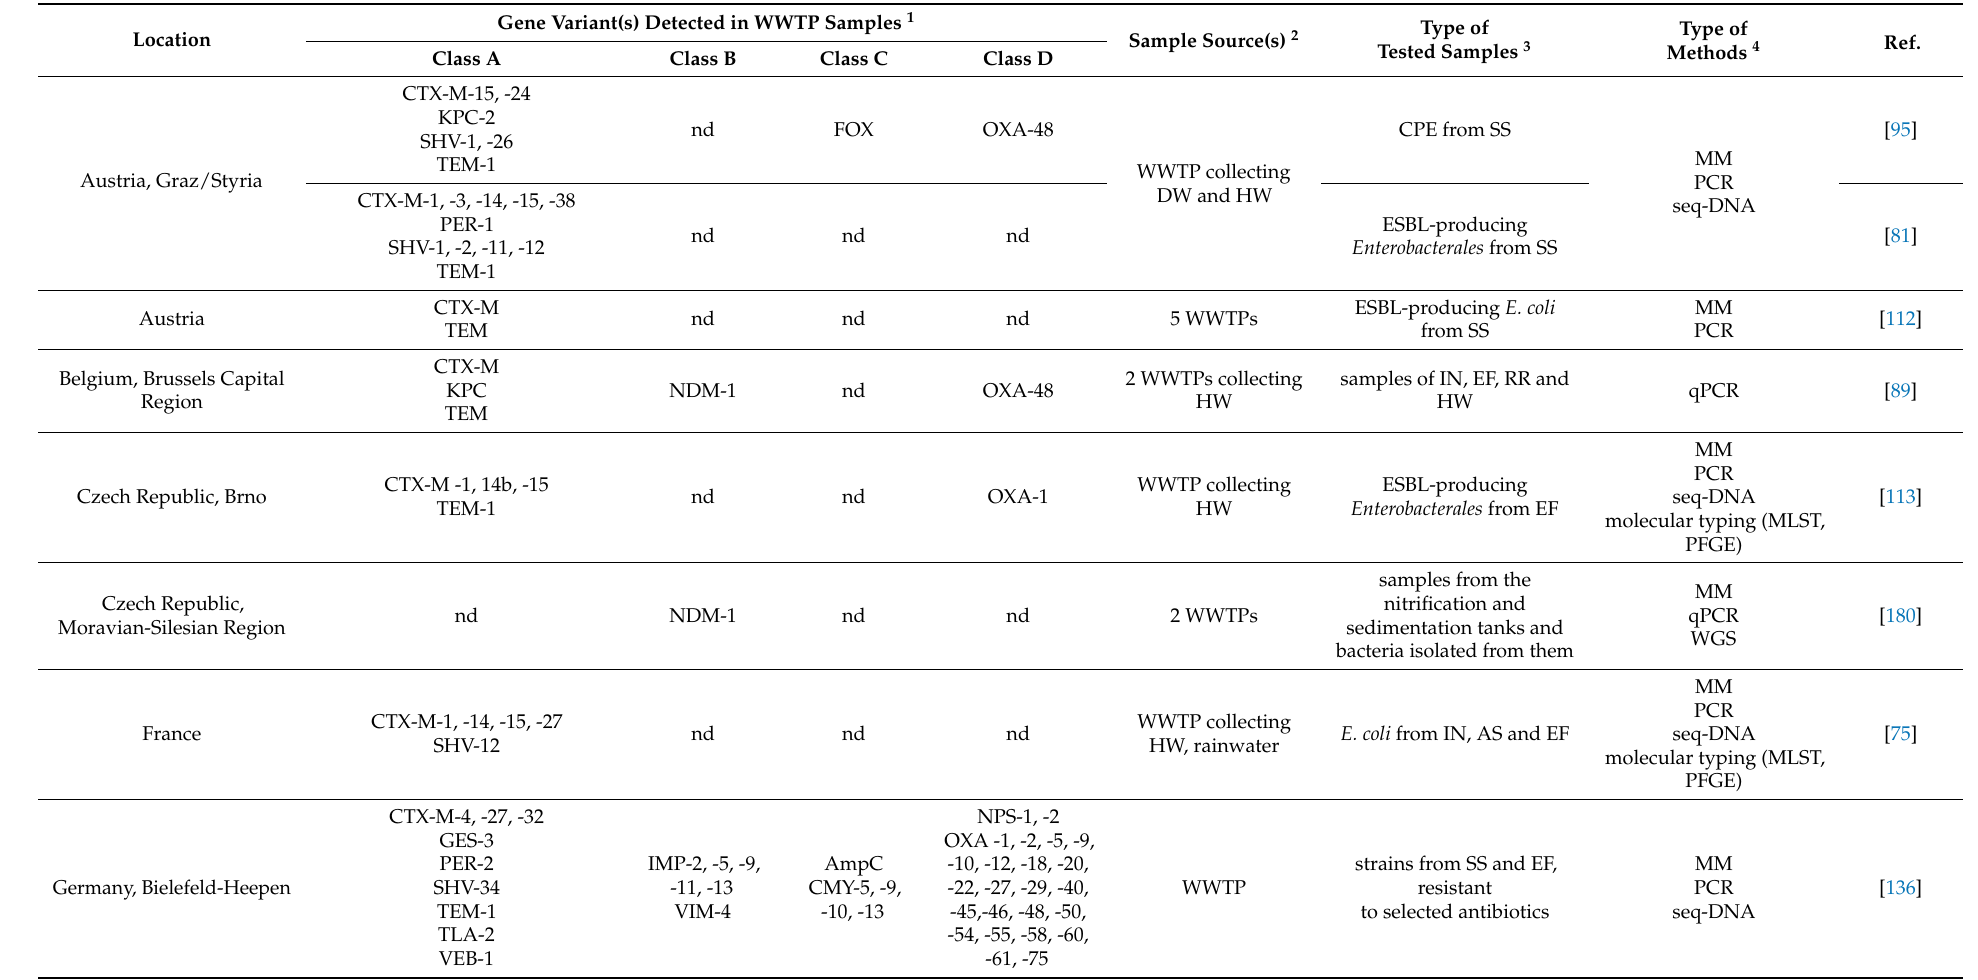
Table 1. ARGs encoding class A, B, C, and D β -lactamases detected in WWTPs-linked